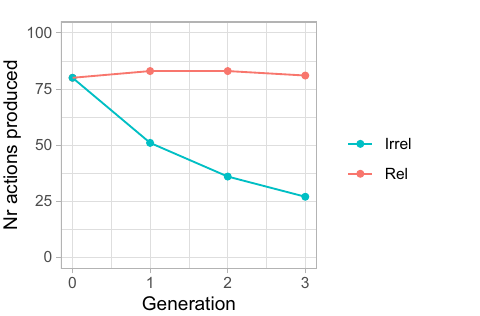
Marginal R ²: 0.1, Conditional R ²: 0.1 Estimates are on the logit scale.